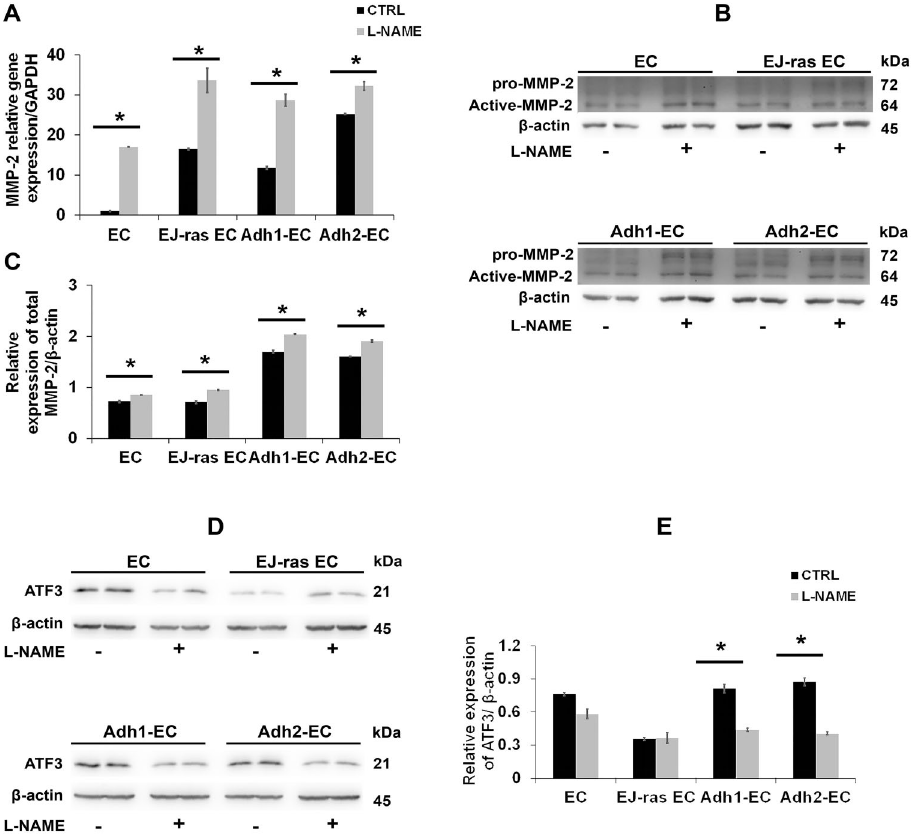
Figure 6. L-NAME treatment up-regulates MMP-2 gene and protein expression, and down-regulates activating transcription factor 3 (ATF3) protein expression in EC-derived cell lines. A , MMP-2 gene expression after nitric oxide (NO) release inhibition of EC, EJ-ras EC, Adh1-EC, and Adh2-EC cells. B , Western blot images of MMP-2 expression after NO release inhibition in EC-derived cell lines. C , Histogram depicting MMP-2 protein levels normalized to b -actin. D , Western blot images of ATF3 expression after NO release inhibition in EC-derived cell lines. E , Histogram depicting ATF3 protein levels normalized to b -actin. The experiments were performed in duplicate and repeated twice. CTRL: Control; EC: parental endothelial cells; EJ-ras EC: EJ-ras transfected endothelial cells; Adh1-EC and Adh2-EC: anoikis-resistant endothelial cells. Data are reported as means ± SE. *P o 0.05 compared to control ( t